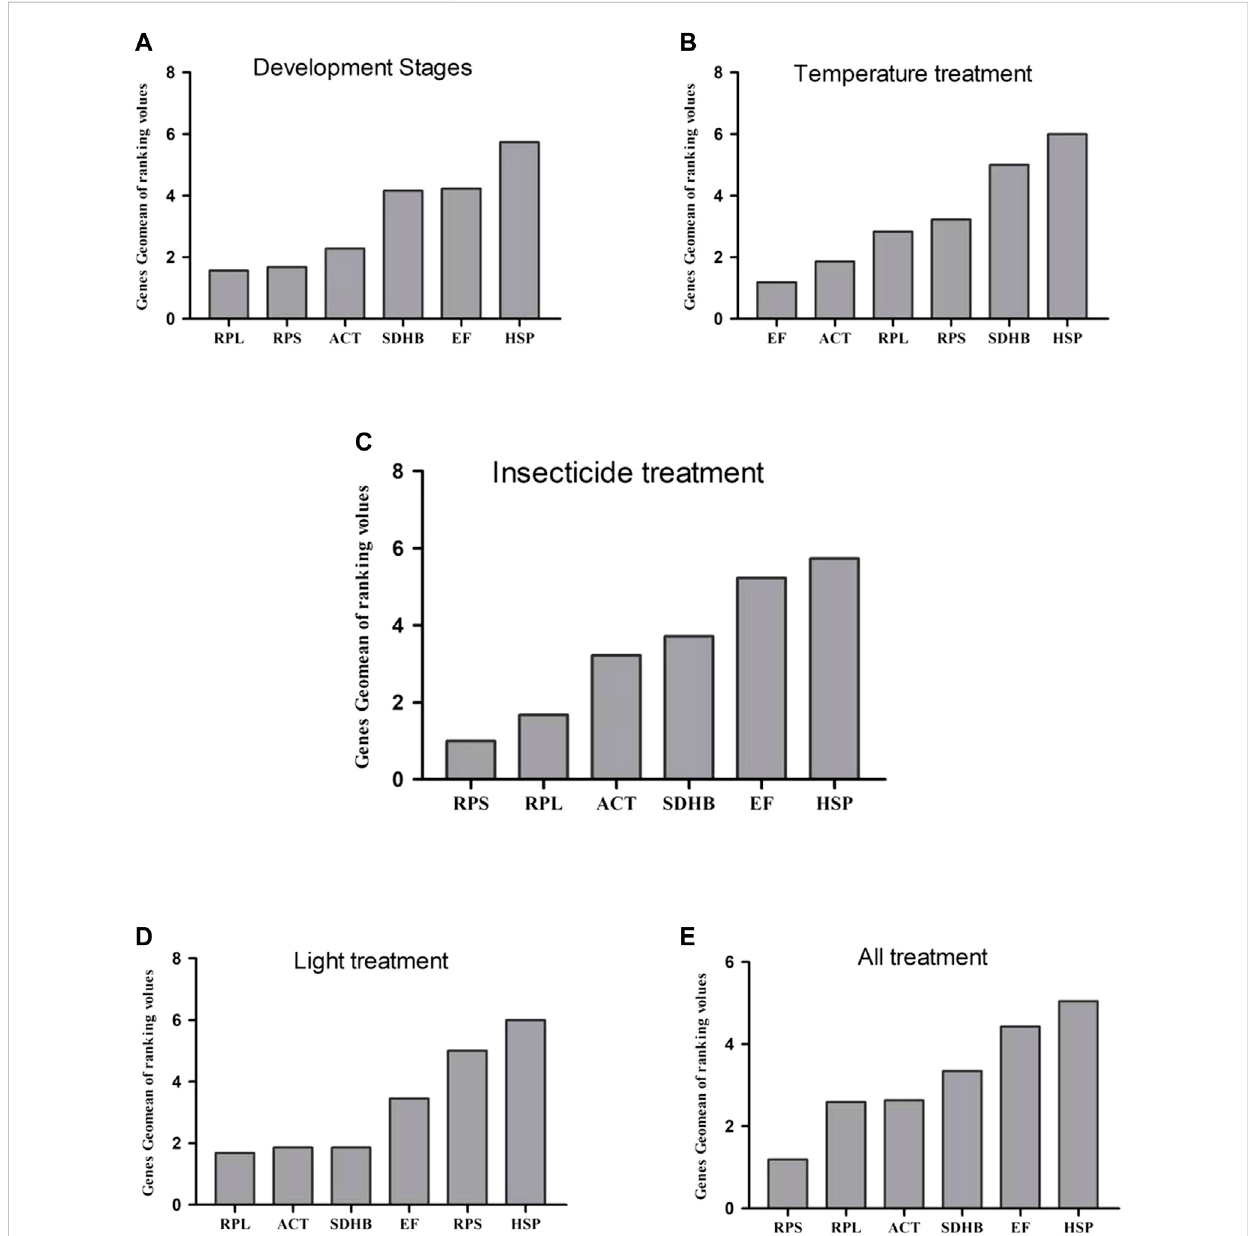
FIGURE 2 Expression stability of 6 reference genes in different samples. RefFinder geometric method was used to calculate the overall stability ranking of thereferencegenes.AlowerGeomeanofrankingvaluedenotesmorestableexpression. (A) developmentstages; (B) insecticide; (C) temperature; (D) light; (E) The four treatments were analyzed